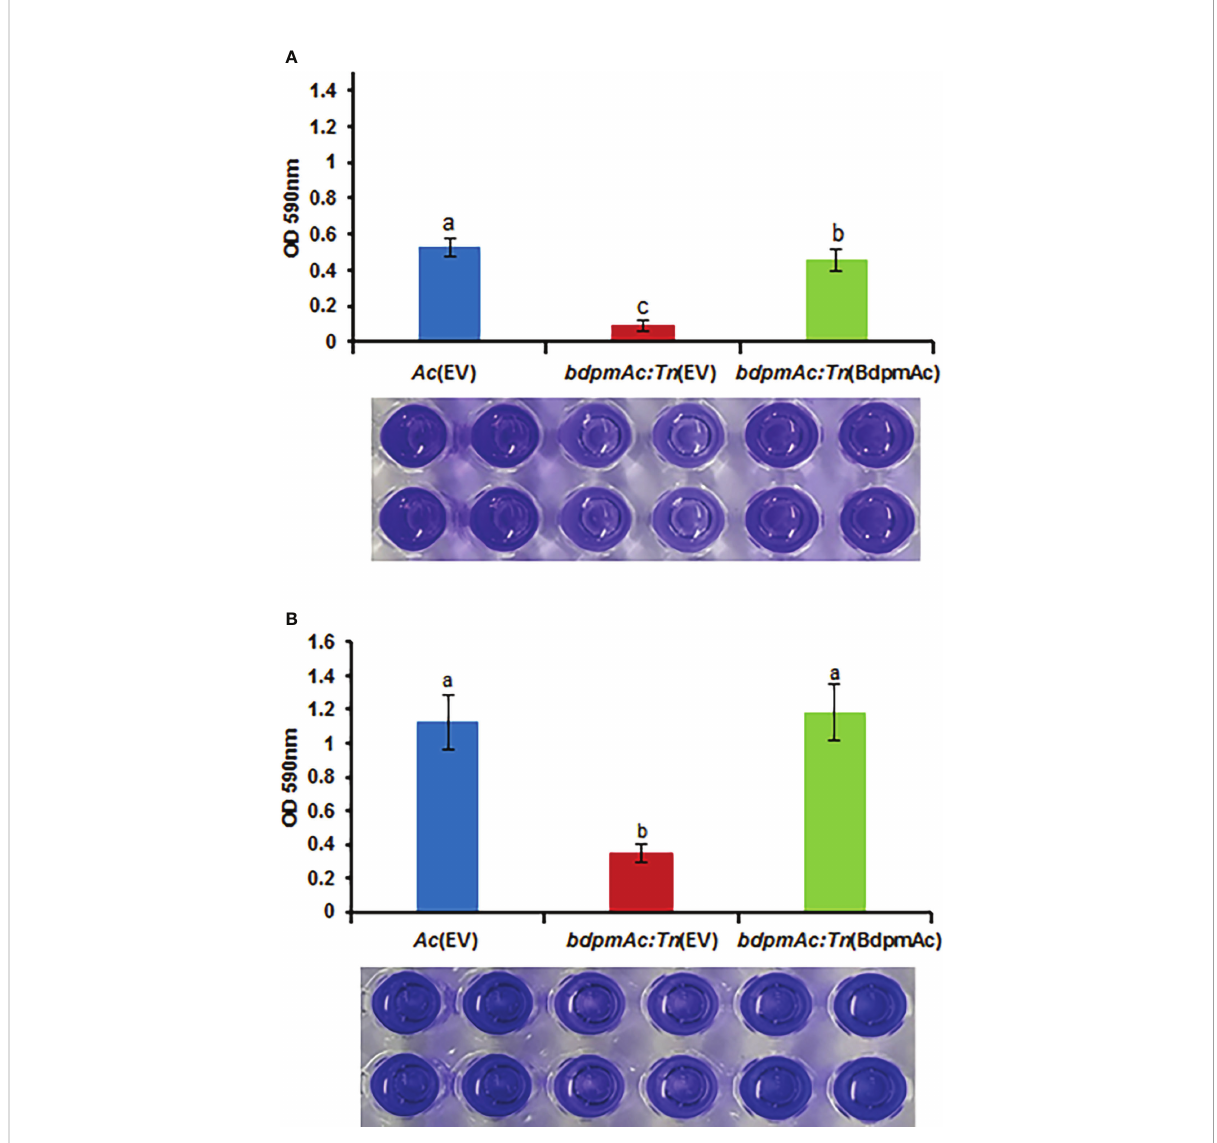
FIGURE 4 Bio fi lm formation in Ac (EV), bdpmAc:Tn (EV), and bdpmAc:Tn (BdpmAc). Ac strains were incubated in polyvinyl chloride 96-well plates for (A) one and (B) three days after incubation. For quanti fi cation, the formed bio fi lm was stained using 0.1% crystal violet. The stained bio fi lm was dissolved in 95% ethanol and measured using a UV spectrophotometer at OD 590nm . The error bars indicate the standard deviations of twenty biological replicates and different characters above the error bars indicate signi fi cant differences according to ANOVA (p<0.05) with Tukey ’ s HSD test. Eight independent experiments were conducted, all of which exhibited similar